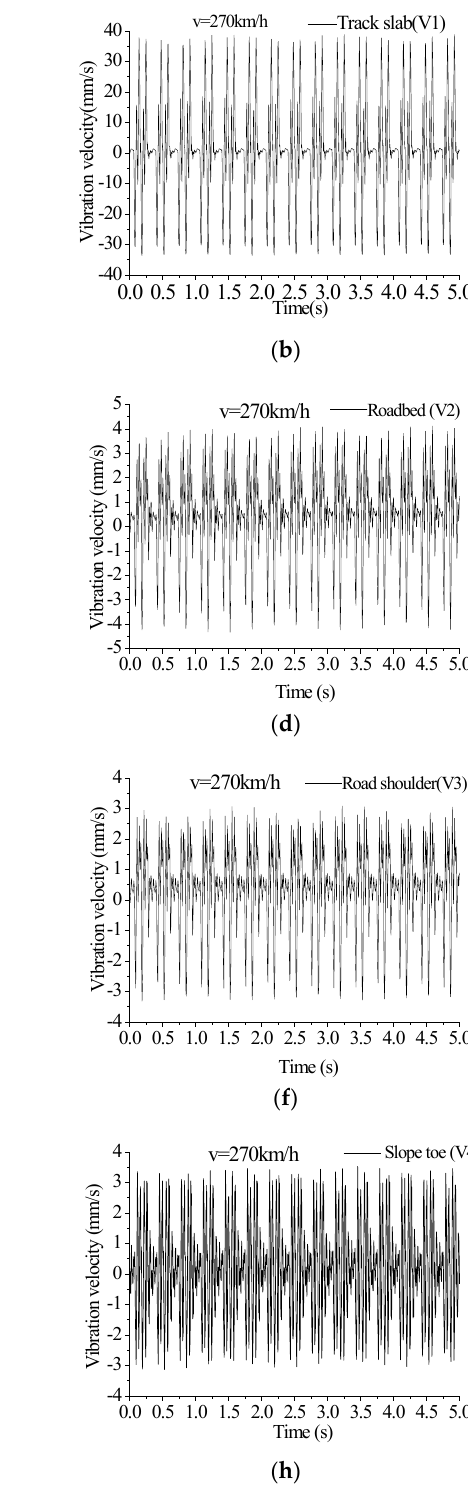
Figure 7. Time history curves of the vibration velocities at the track slab, roadbed, road shoulder, and slope toe for different train speeds. ( a ) Track slab (V1, v = 90 km/h), ( b ) Track slab (V1, v = 270 km/h), ( c ) Roadbed (V2, v = 90 km/h), ( d ) Roadbed (V2, v = 270 km/h), ( e ) Road shoulder (V3, v = 90 km/h), ( f ) Road shoulder (V3, v = 270 km/h), ( g ) Slop toe (V4, v = 90 km/h), ( h ) Slop toe (V4, v = 270 km/h).